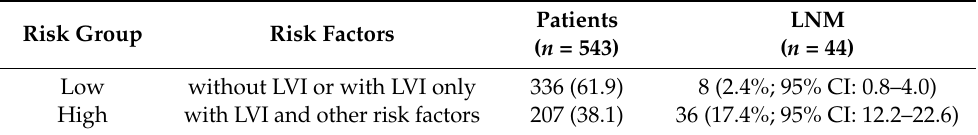
Table 5. Lymph node metastasis rate after risk